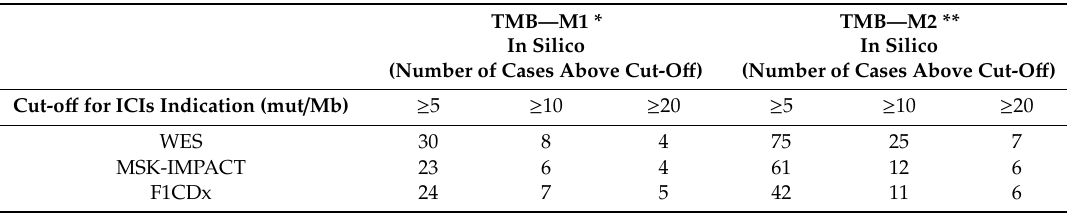
Table 4. WES-based TMB values during tumor progression in nine patient case